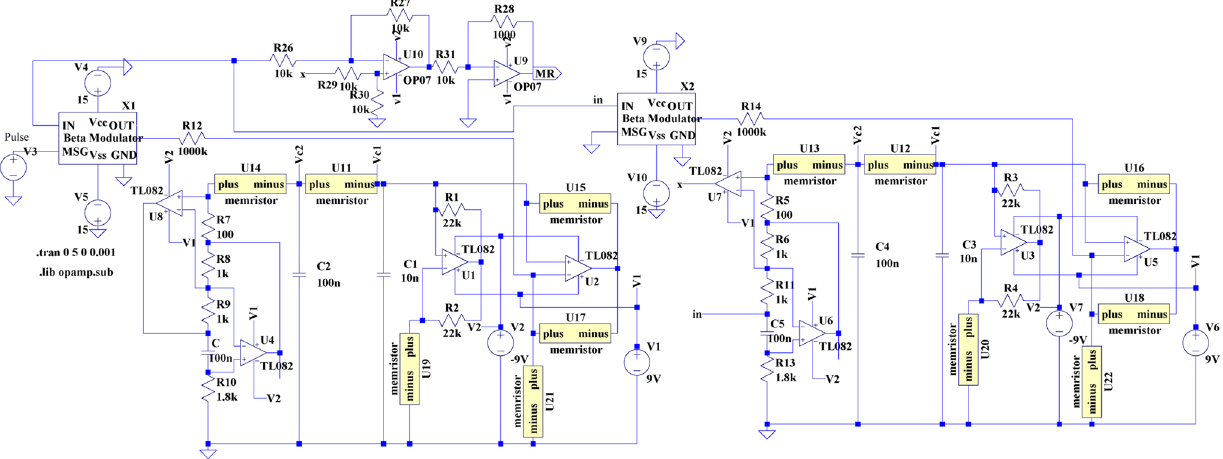
Fig. 10 LTSpice design of transmitter and receiver for memristor-based Chua’s chaotic